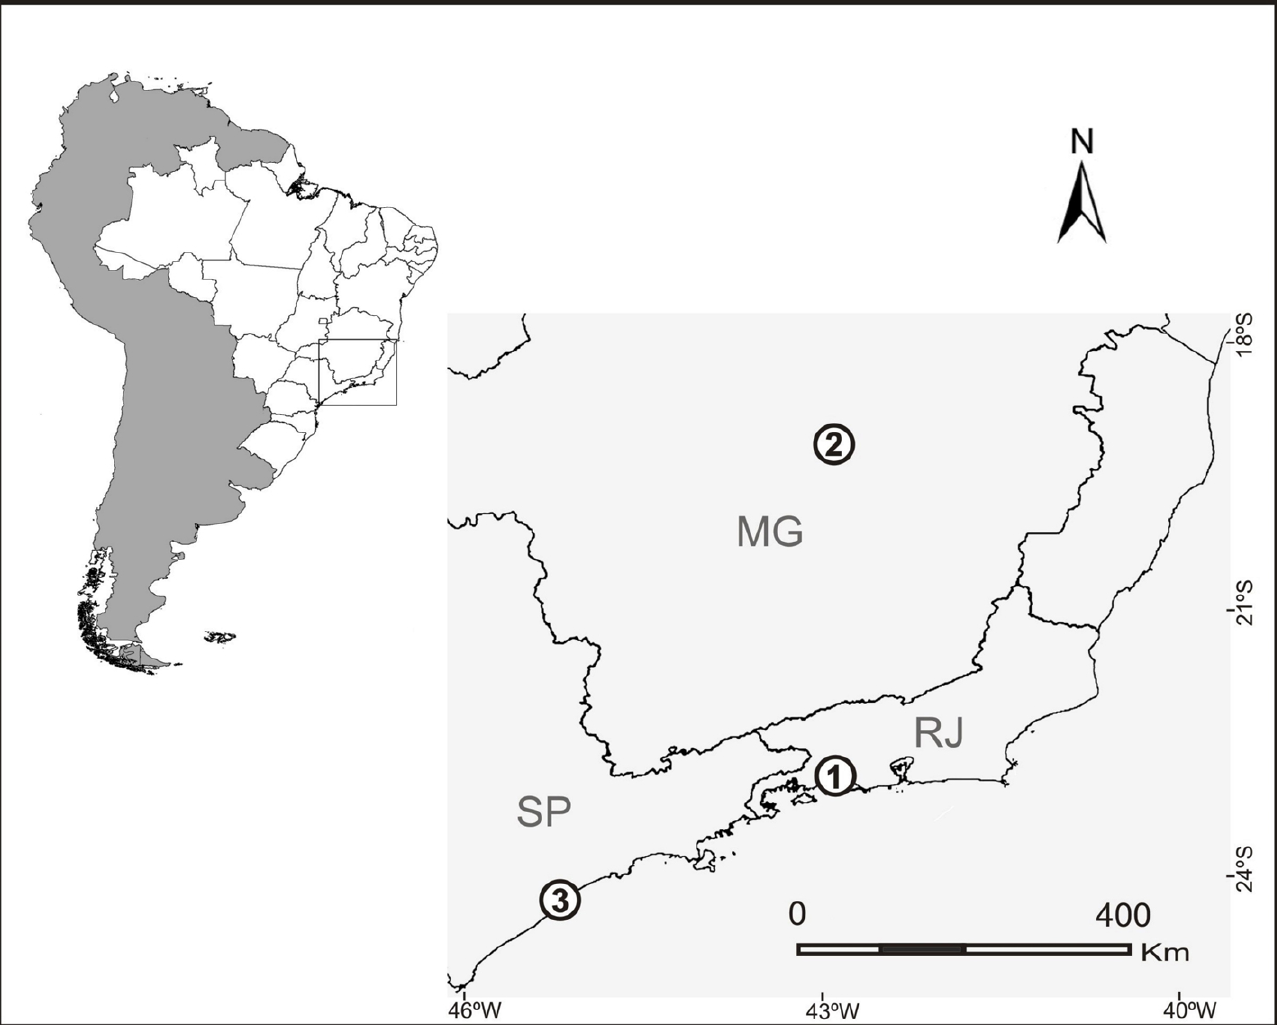
Figure 2. Documented records of the Gull-billed Tern, Gelochelidon nilotica, in the states of southeastern Brazil: 1, Rio de Janeiro – RJ (present study); 2, Minas Gerais – MG (Nóbrega et al. 2015); 3, São Paulo – SP (MZUSP